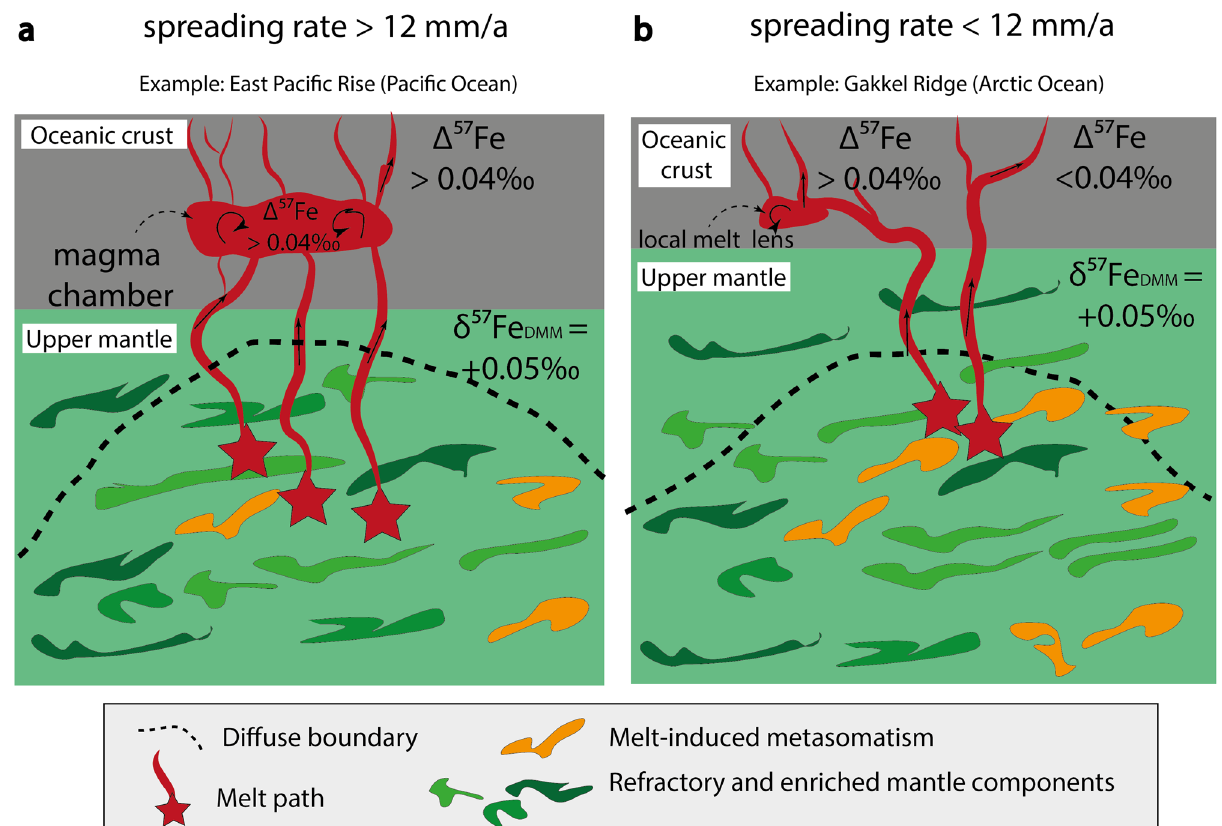
Figure 7. Magma plumbing systems at the Gakkel Ridge. Simplified sketch after Brandl et al. 3 and Nebel et al. 39 , showing magmatic evolution depending on spreading rate differences. Profile A reflects the melt migration and the formation of large mid-crustal magma chambers at spreading rates > 12 mm/a. Melt migrating through magma chambers will be controlled by magma mixing and crystal fractionation affecting the iron isotope composition of the basalts (Δ 57 Fe > 0.04 ‰). Instead, profile B represents the magmatic process for ridge with a rate of < 12 mm/a. In this case, magma travels from its source region to its surface without or minor interaction in magma pools, which is reflected by lower degree of isotope fractionation (Δ 57 Fe < 0.04